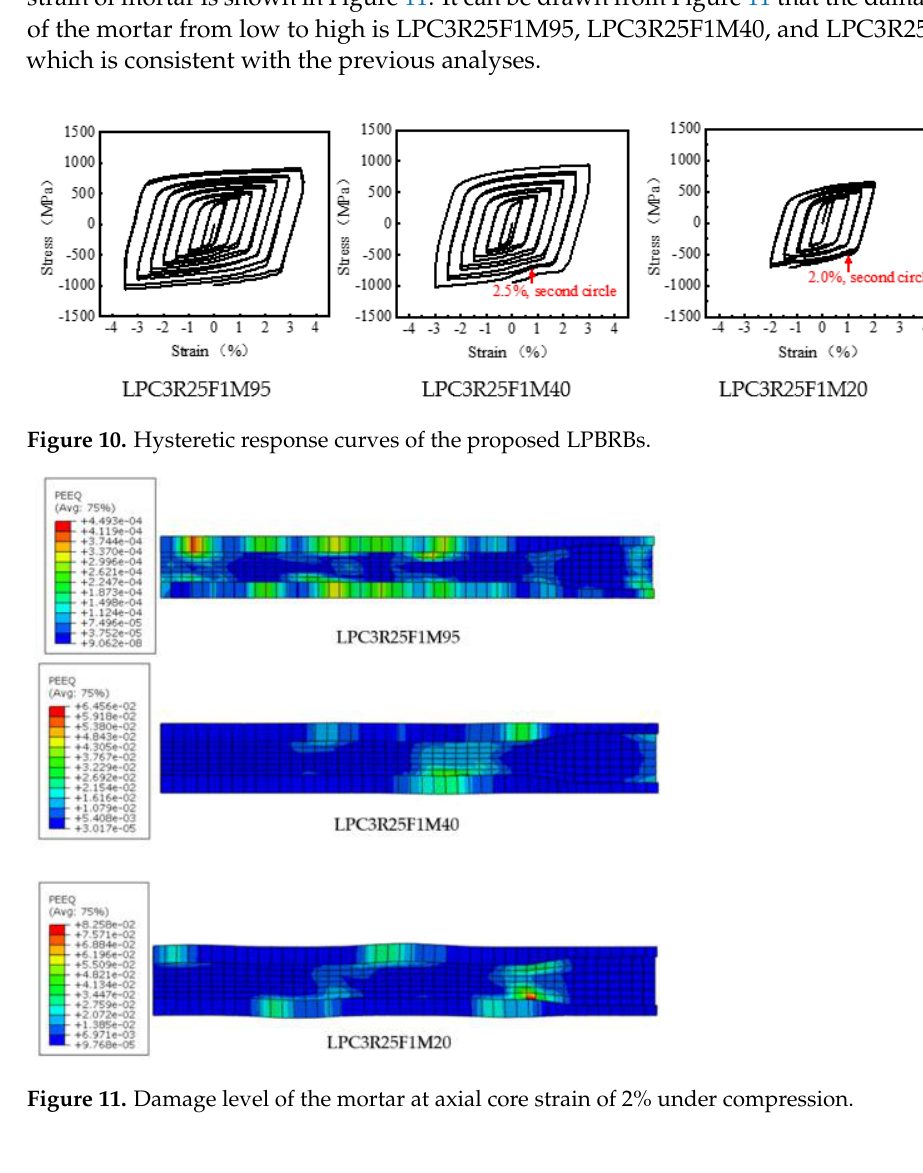
Figure 9. Hysteretic response curves of the proposed LPBRBs.